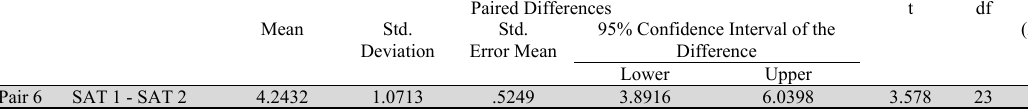
Paired Differences